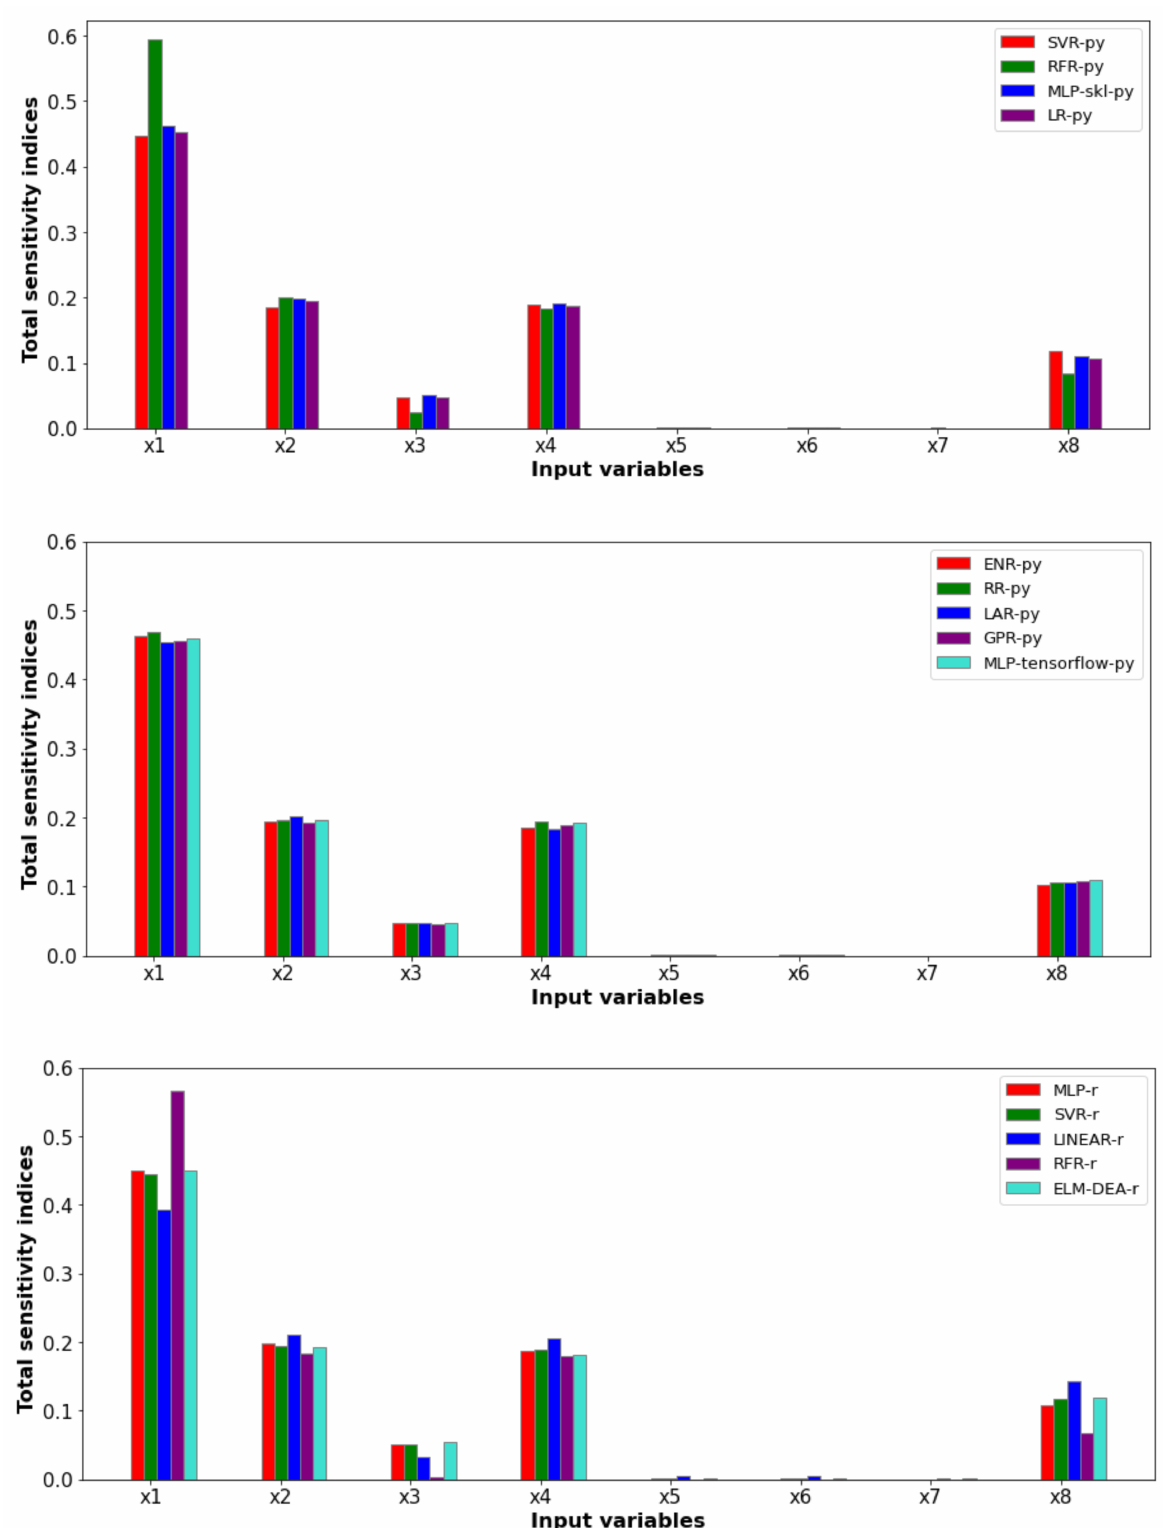
Figure 5. Total sensitivity indices obtained via the Sobol–Jansen method and surrogate models for comminution-specific